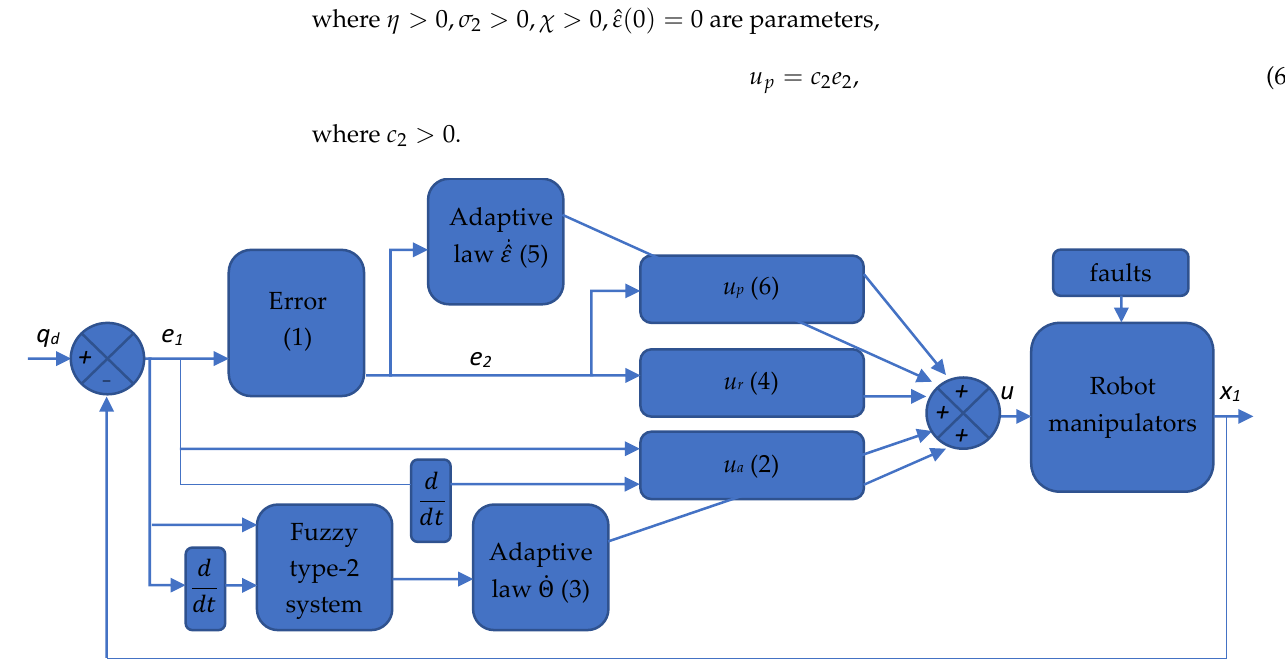
Figure 1. AFT2BC control scheme [17], where u are the desired robot axes’ positions.